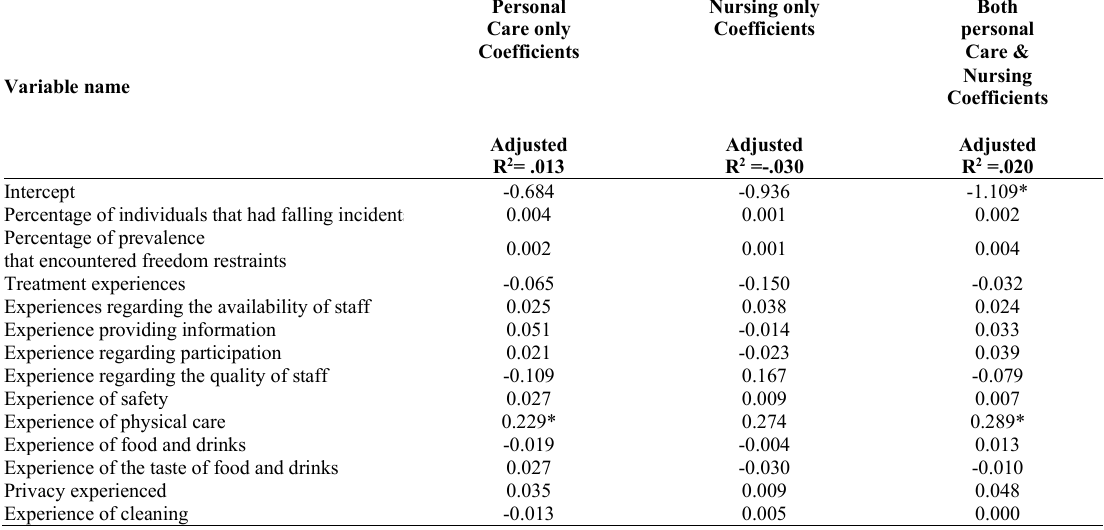
Linear regression model for patient experiences in relation to